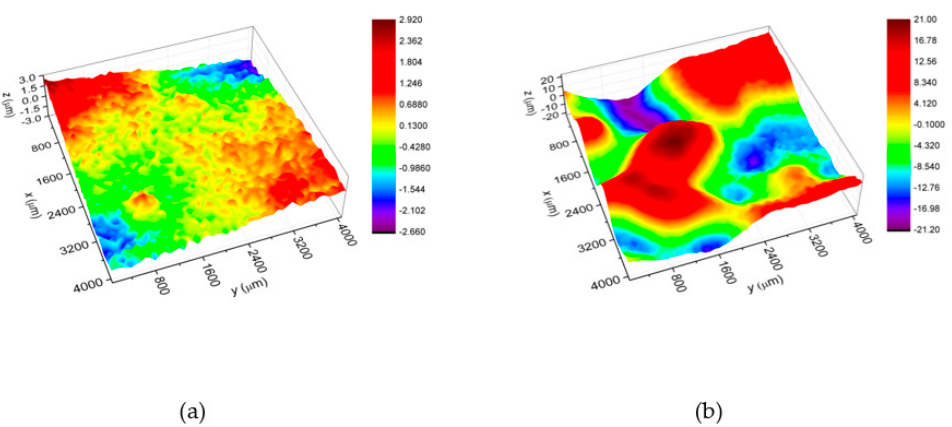
Figure 8. Topography maps determined for the heat-treated Ni-W coatings: ( a ) C125/1173 and ( b ) C200/1173.